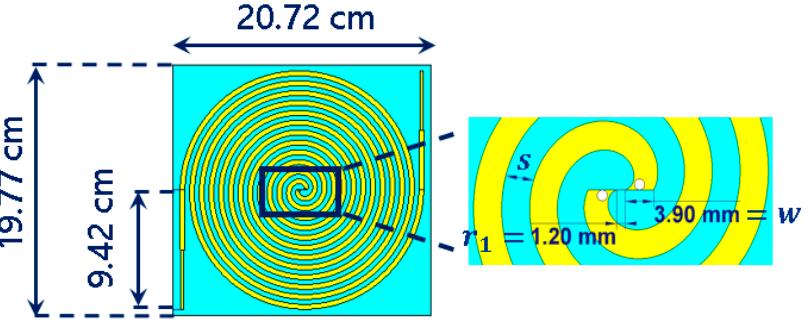
Figure 3. Archimedean spiral antenna.